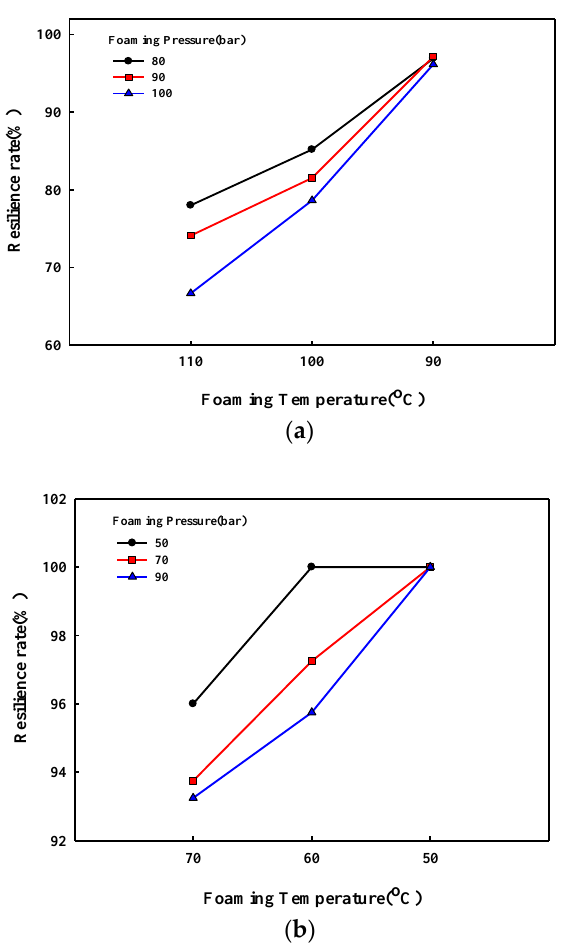
Figure 5. Resilience characteristics of P(3HB- co -4HB) foams; ( a ) crystalline P(3HB- co -16% 4HB); ( b ) non-crystalline P(3HB- c o-30% 4HB).